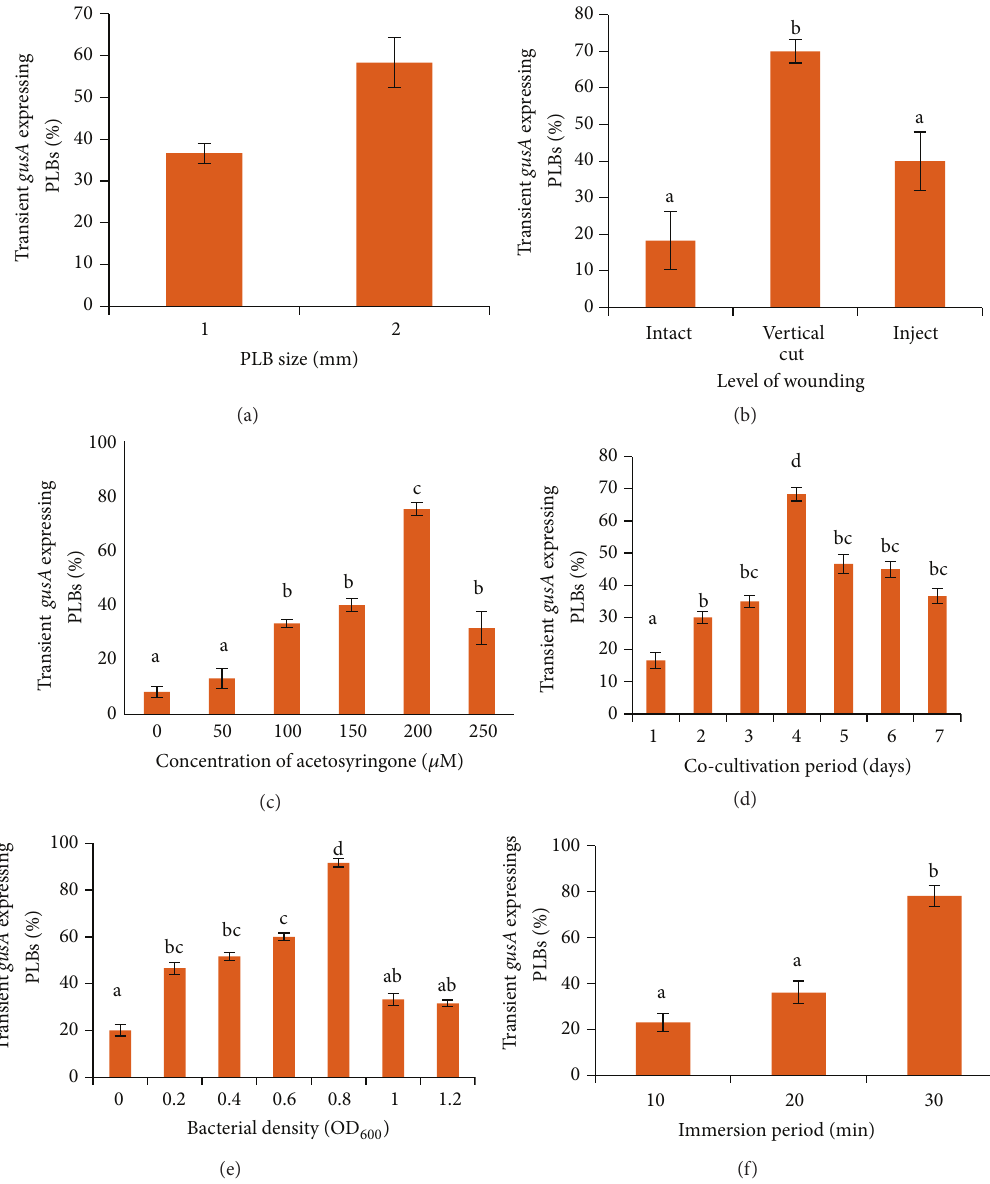
Figure 4: Optimization of the Agrobacterium -mediated transformation based on transient gusA expression on VKD’s PLBs. (a) PLB size; (b) wounding; (c) concentration of acetosyringone; (d) cocultivation period; (e) Agrobacterium density; and (f) Immersion period. Results were analysed by one-way ANOVA and means were compared by Tukey’s test. Vertical bars represent ± SE of means of 6 replicates. Different letters indicate values which are significantly different (𝑃 ≤ 0.05)